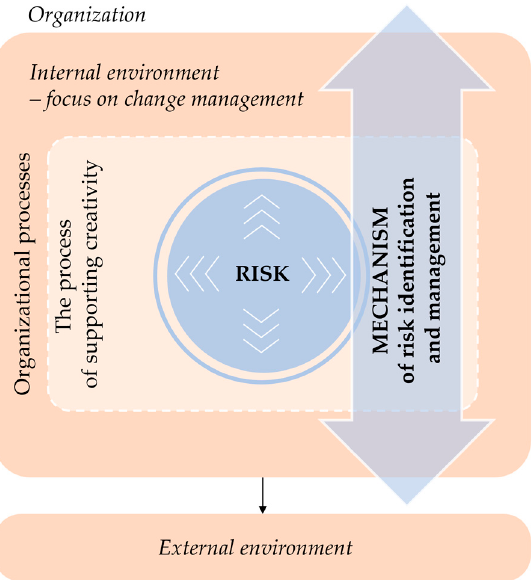
Figure 1. The impact of risk on organizational processes and its effect on the state of the economy in the country (own elaboration).